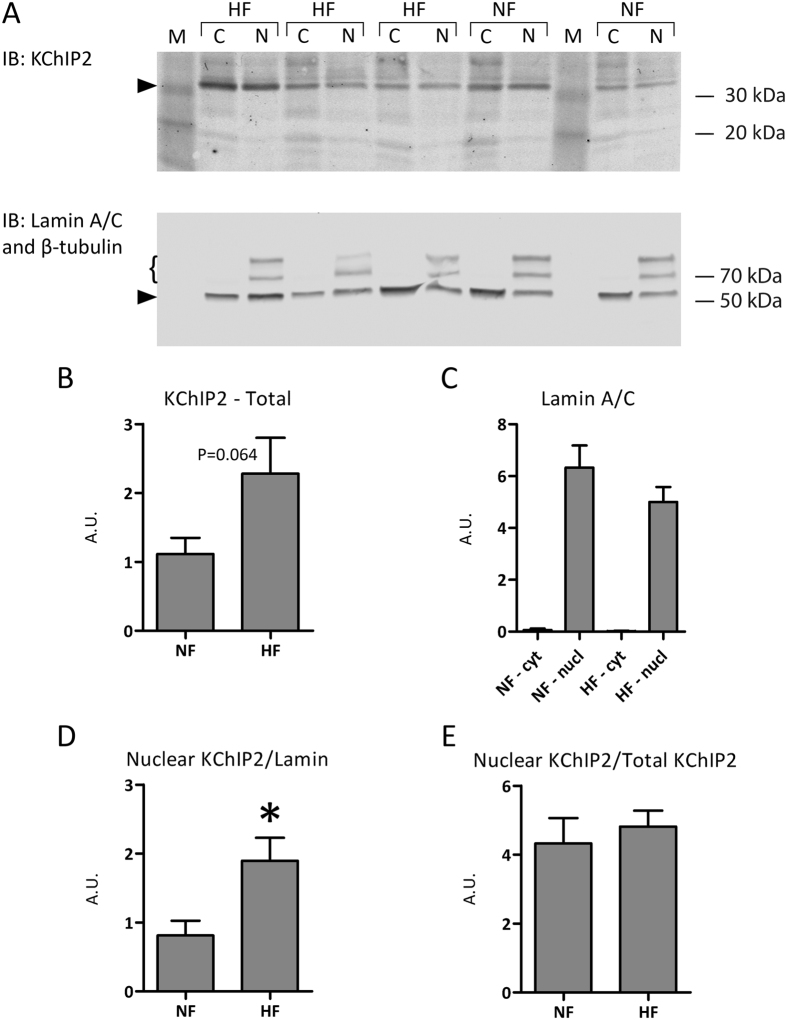
KChIP2 expression and subcellular localization in human hearts.(A) Representative immunoblots showing detection of KChIP2 in cytosolic (C) and nuclear (N) protein fractions from heart samples from heart-failure (HF; n = 3) and non-failing (NF; n = 2) patients. Lanes with molecular weight marker are indicated with M. Arrowheads indicate KChIP2 and β-tubulin bands in the upper and lower panel, respectively. The double band of lamin A/C is indicated with a “{”. Detecting β-tubulin and Lamin A/C confirms equal loading of cytosolic protein and successful fractionation, respectively. Each sample is analyzed in duplicate. (B) Quantification of the total amount of KChIP2 in the two experimental groups. (C) Quantification of Lamin A/C in nuclear and cytosolic fractions. (D) Ratio of the nuclear KChIP2 and nuclear Lamin A/C in NF and HF samples (*P = 0.025). (E) Ratio of the nuclear KChIP2 to total KChIP2. P values from Student’s t test.